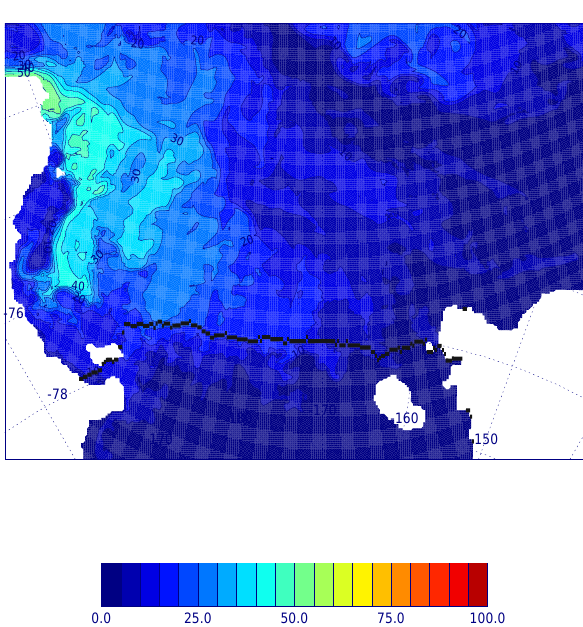
Fig. 6. CDW dye on model level 12 (mid-depth) for 1 Novem- ber 2002. Dye values of 100 are undiluted CDW. The black line represents the position of the Ross Ice Shelf Front.